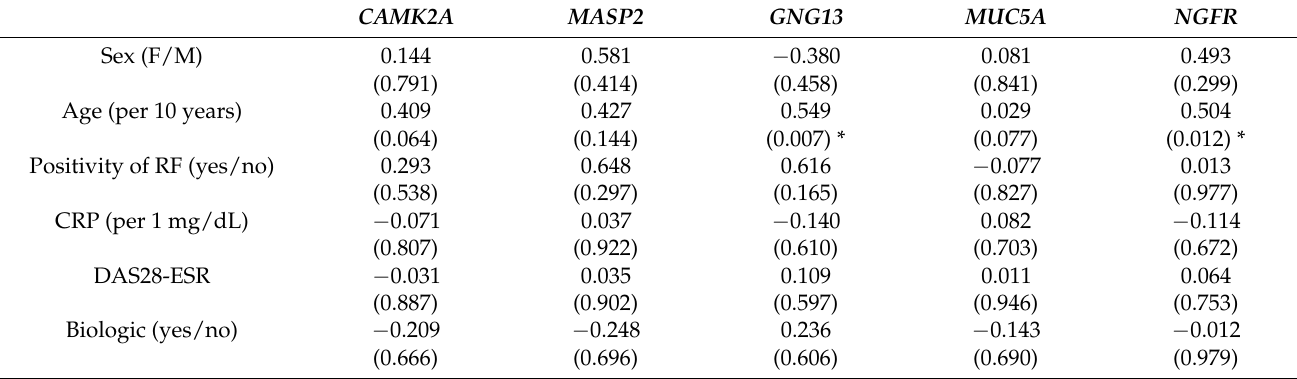
Table 3. Simple and multiple linear regression analyses for assessing the correlations among different clinical parameters, and expression levels of brain-derived neurotrophic factor (BDNF) regulated genes in T cells of patients with rheuma- toid